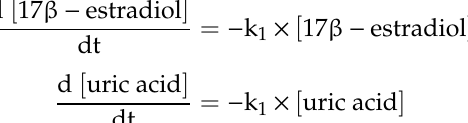
) 11.66 mL · s − 1 ; (cid:35)